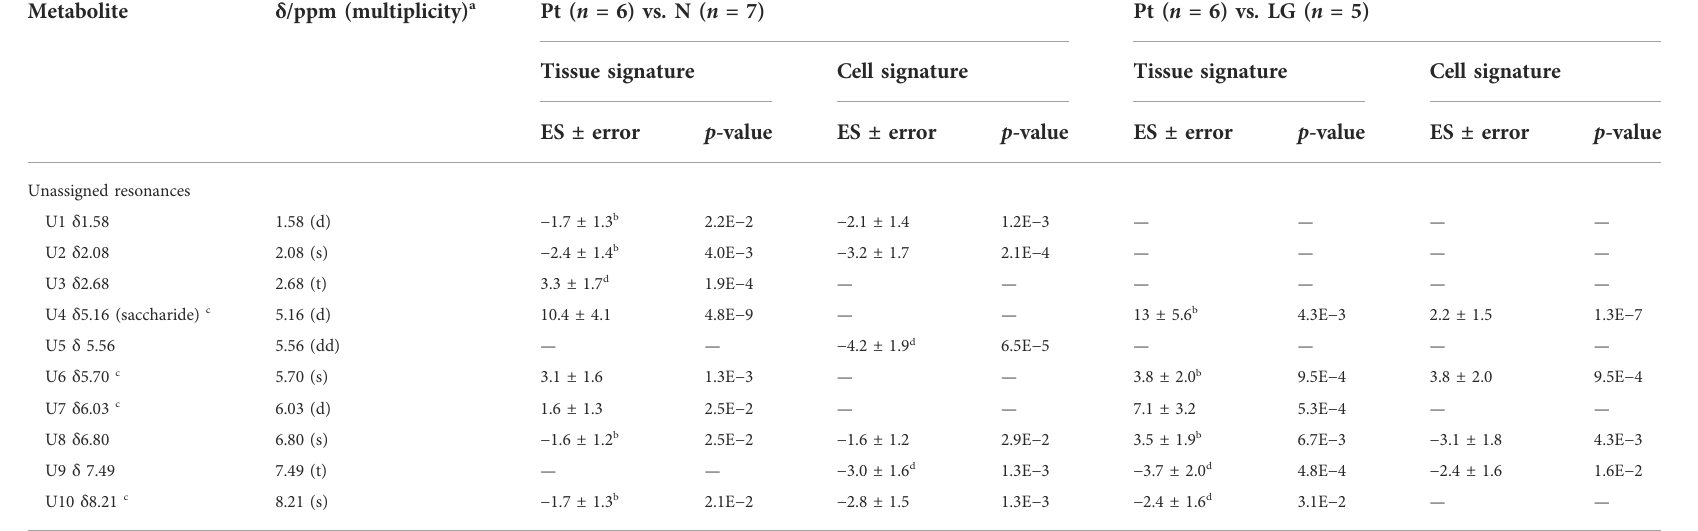
TABLE 2 ( Continued ) Polar pancreatic metabolites varying between pancreatitis induced-mice (Pt) and normal tissue (N) (left), and between Pt and LG PanIN lesions (LG)